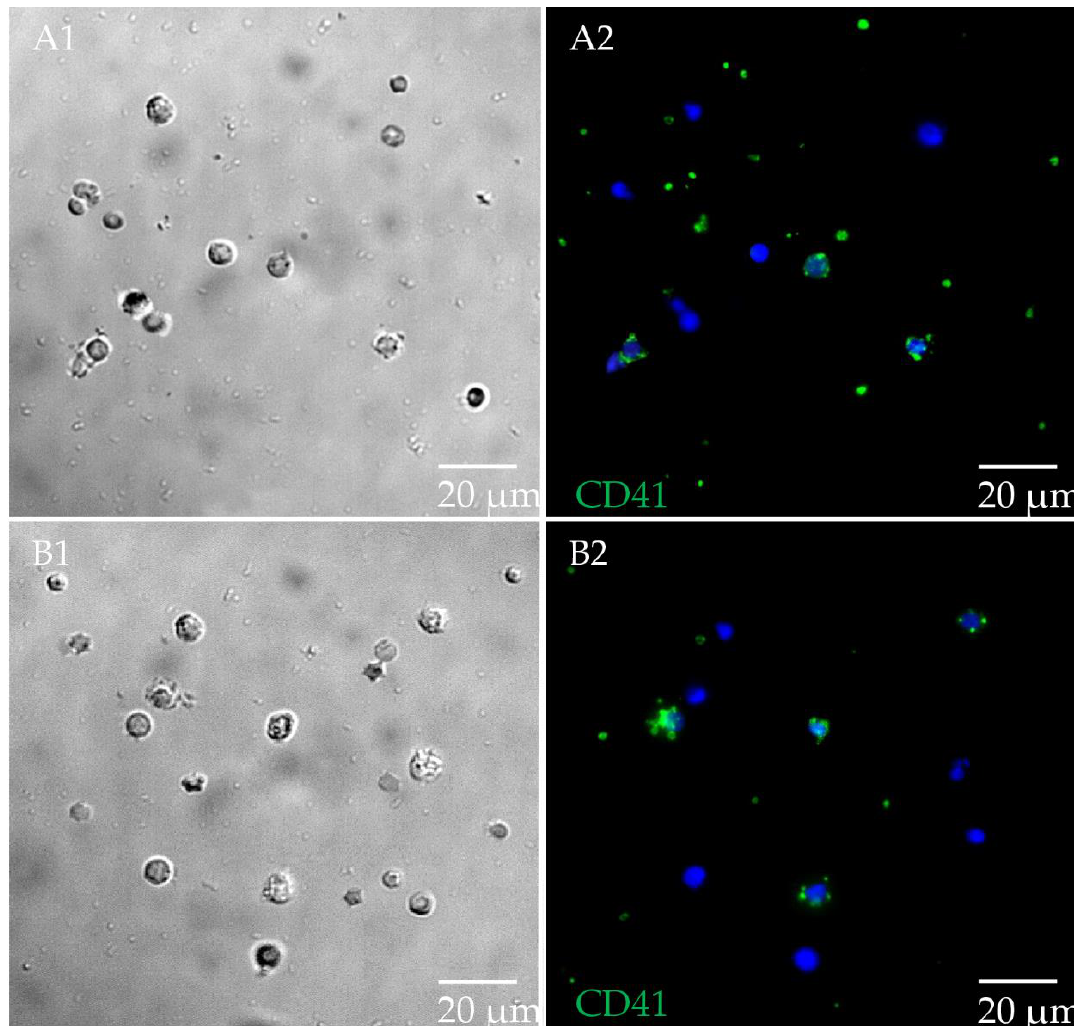
Figure 3. CD41 on PBMC from MAP-resistant and persistently MAP-infected cows. ( A1 ) Differential interference contrast (DIC) imaging of PBMC from MAP-resistant cows. ( A2 ) CD41 (in green) in PBMC from MAP-resistant cows (nuclei stained with 4 ′ ,6-diamidino-2-phenylindole (DAPI)). CD41 expression identified on platelets and PBMC from MAP-resistant cows. ( B1 ) DIC of PBMC from persistently MAP-infected cows. ( B2 ) CD41 (in green) in persistently MAP-infected cows. CD41 expression on platelets and PBMC of persistently MAP-infected cows (all representative images). Image sizes are annotated by scale bar in lower right corner of respective image.